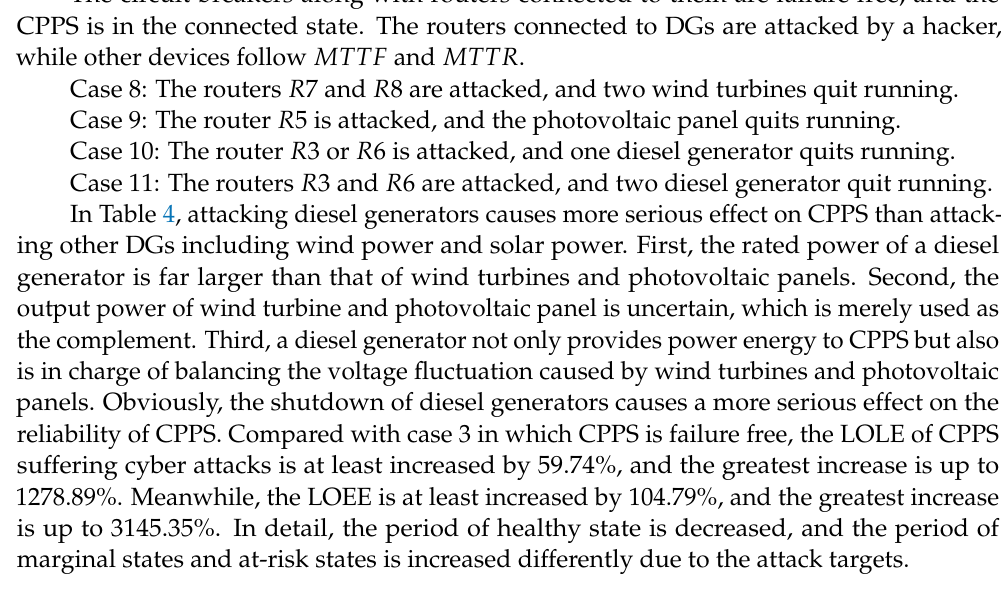
Table 4. Reliability